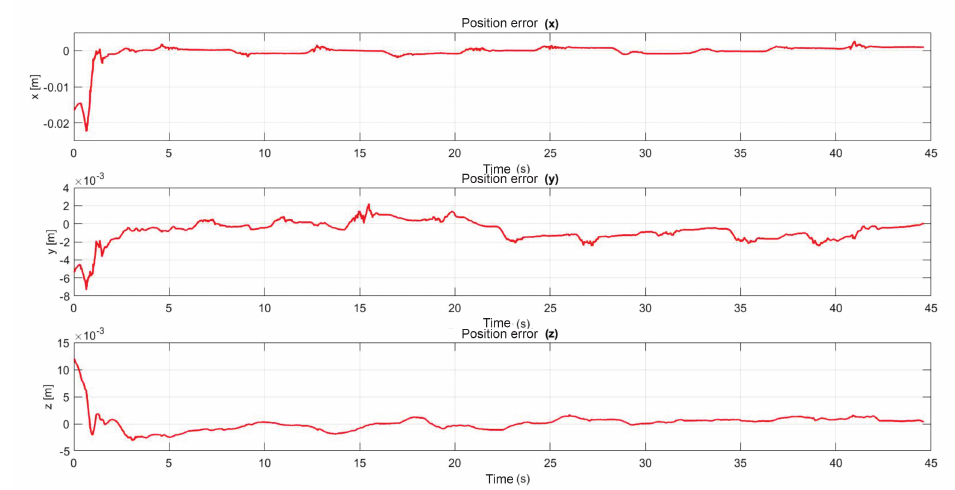
Figure 29. Position error of right haptic device: exercise 3.